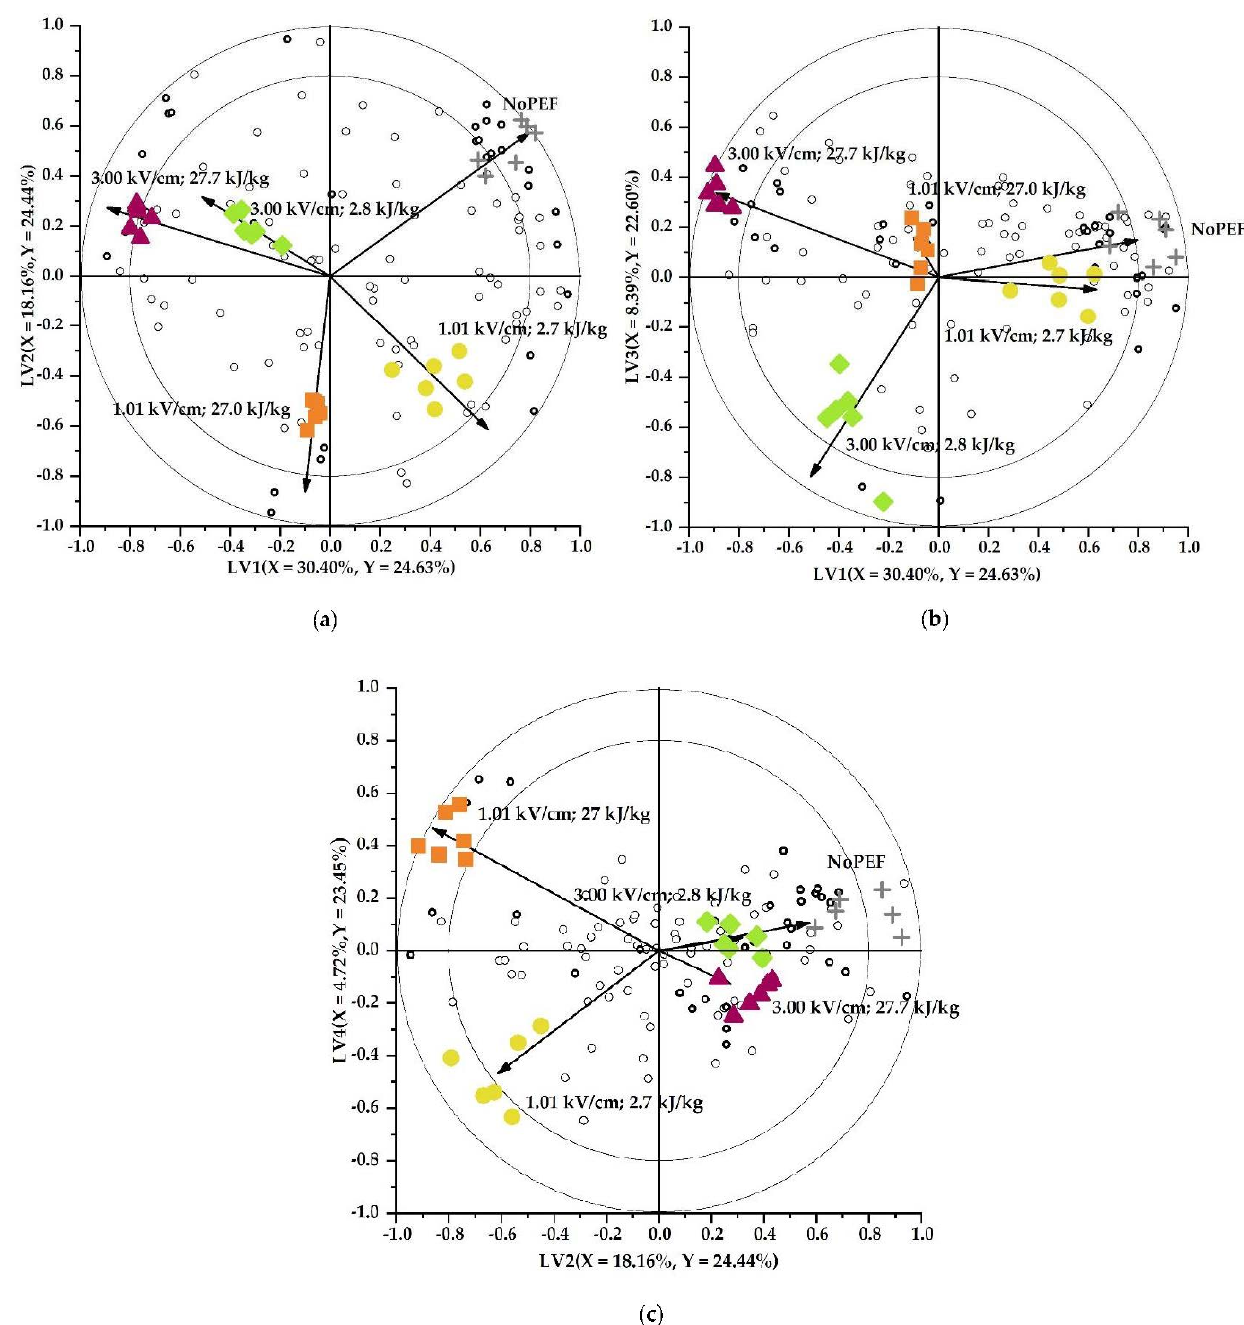
Figure 4. PLS-DA biplots visualizing the effect of different PEF conditions (( + ) NoPEF, ( • ) 1.01 kV/cm and 2.7 kJ/kg, ( ) 1.01 kV/cm and 27 kJ/kg, ( ♦ ) 3.00 kV/cm and 2.8 kJ/kg, and ( ) 3.00 kV/cm and 27.7 kJ/kg) on the volatile profile of Brussels sprouts. Open circles (o) on the biplots represent the headspace components with the discriminant components marked in bold (|VID| ≥ 0.800) ( o ). Vectors depict the correlation loadings for the categorical Y -variables. The variance explained by each LV is indicated on the respective axes. The inner and outer circles depict the correlation coefficients of 0.8 and 1.0, respectively. ( a ) LV2 as a function of LV1; ( b ) LV3 as a function of LV1; ( c ) LV4 as a function of